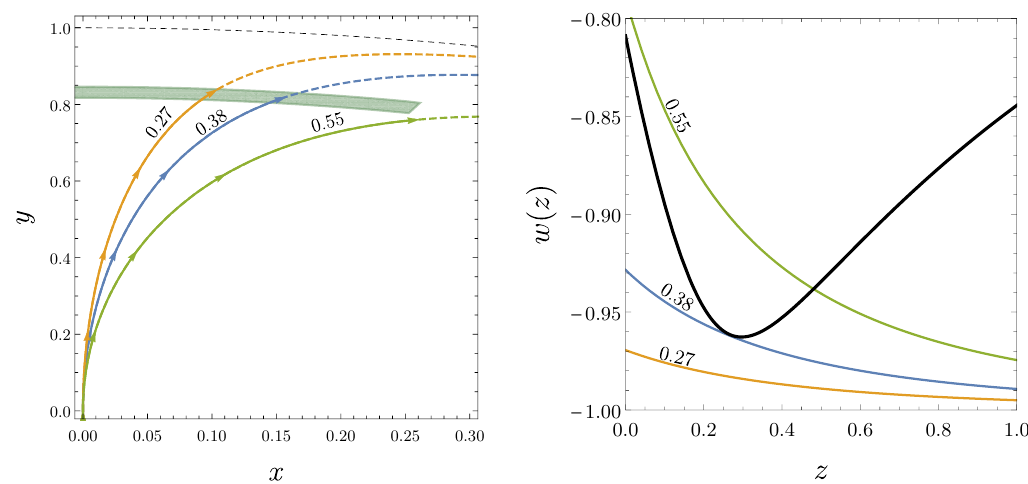
Figure 3 . The ( x; y ) trajectories of the quintessence (cid:12)eld (left) and its equation of state (right) for a range of initial misalignment. For this plot, we have chosen the values ( a; b ) = (1 : 05 ; 1 : 2), for which generic initial conditions are consistent with data. Curves are labeled with the initial (cid:12)eld value (cid:30) init =M Pl and show the minimum and maximum allowed values in addition to a trajectory that is excluded by data.